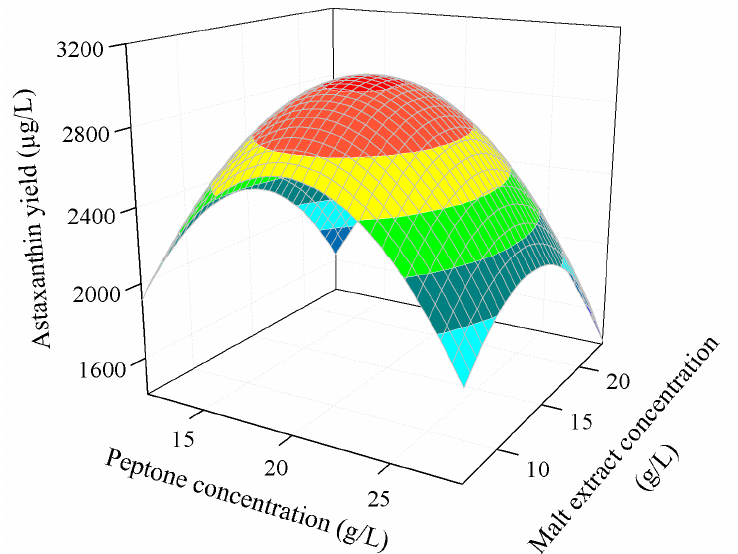
Figure 3. Combined e ff ect of peptone concentration and malt extract concentration on astaxanthin production by R. toruloides mutant.